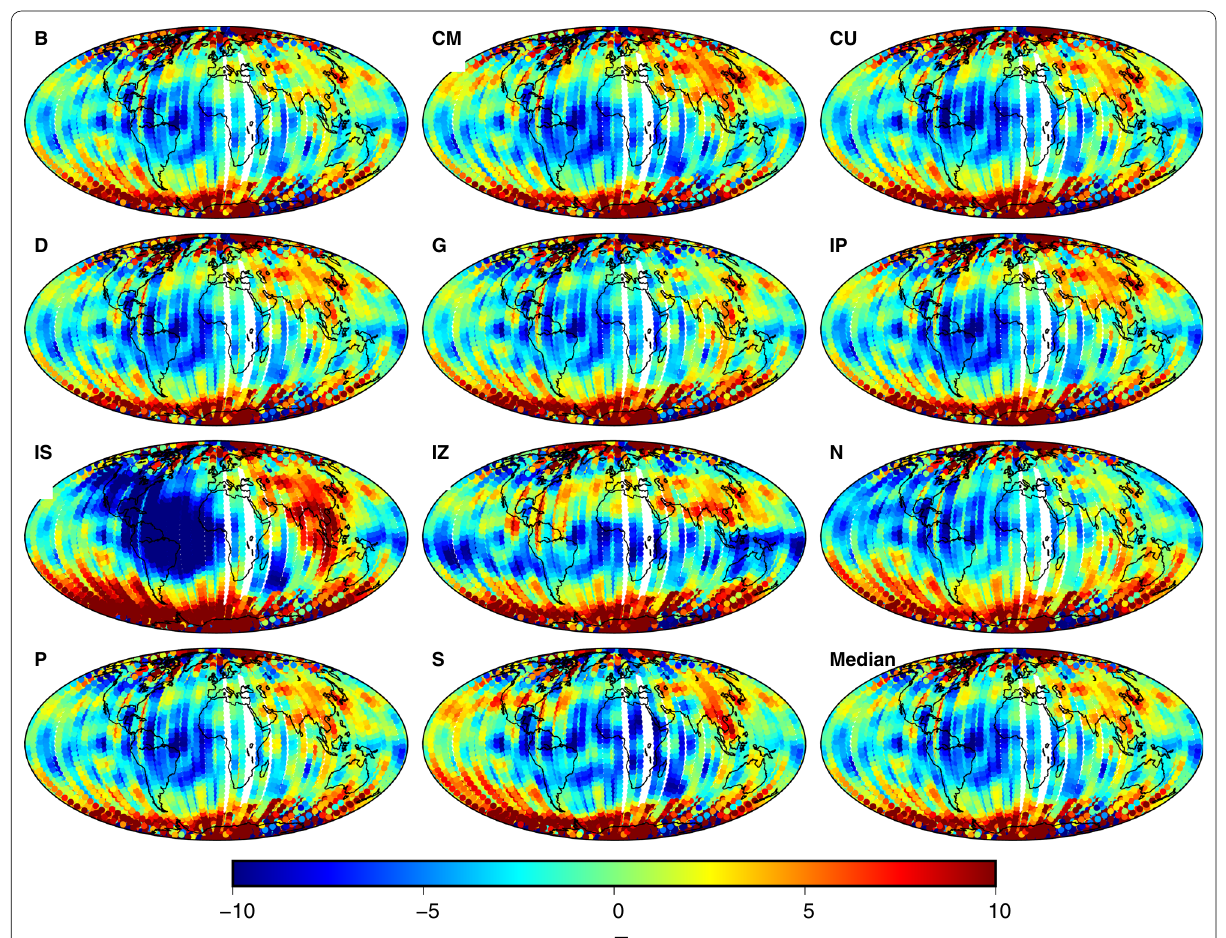
Fig. 4 Vertical component ( B z ) residuals between a combined Swarm A and B dataset and the DGRF-2015 candidates. The Swarm dataset spans 15 December 2014 to 15 January